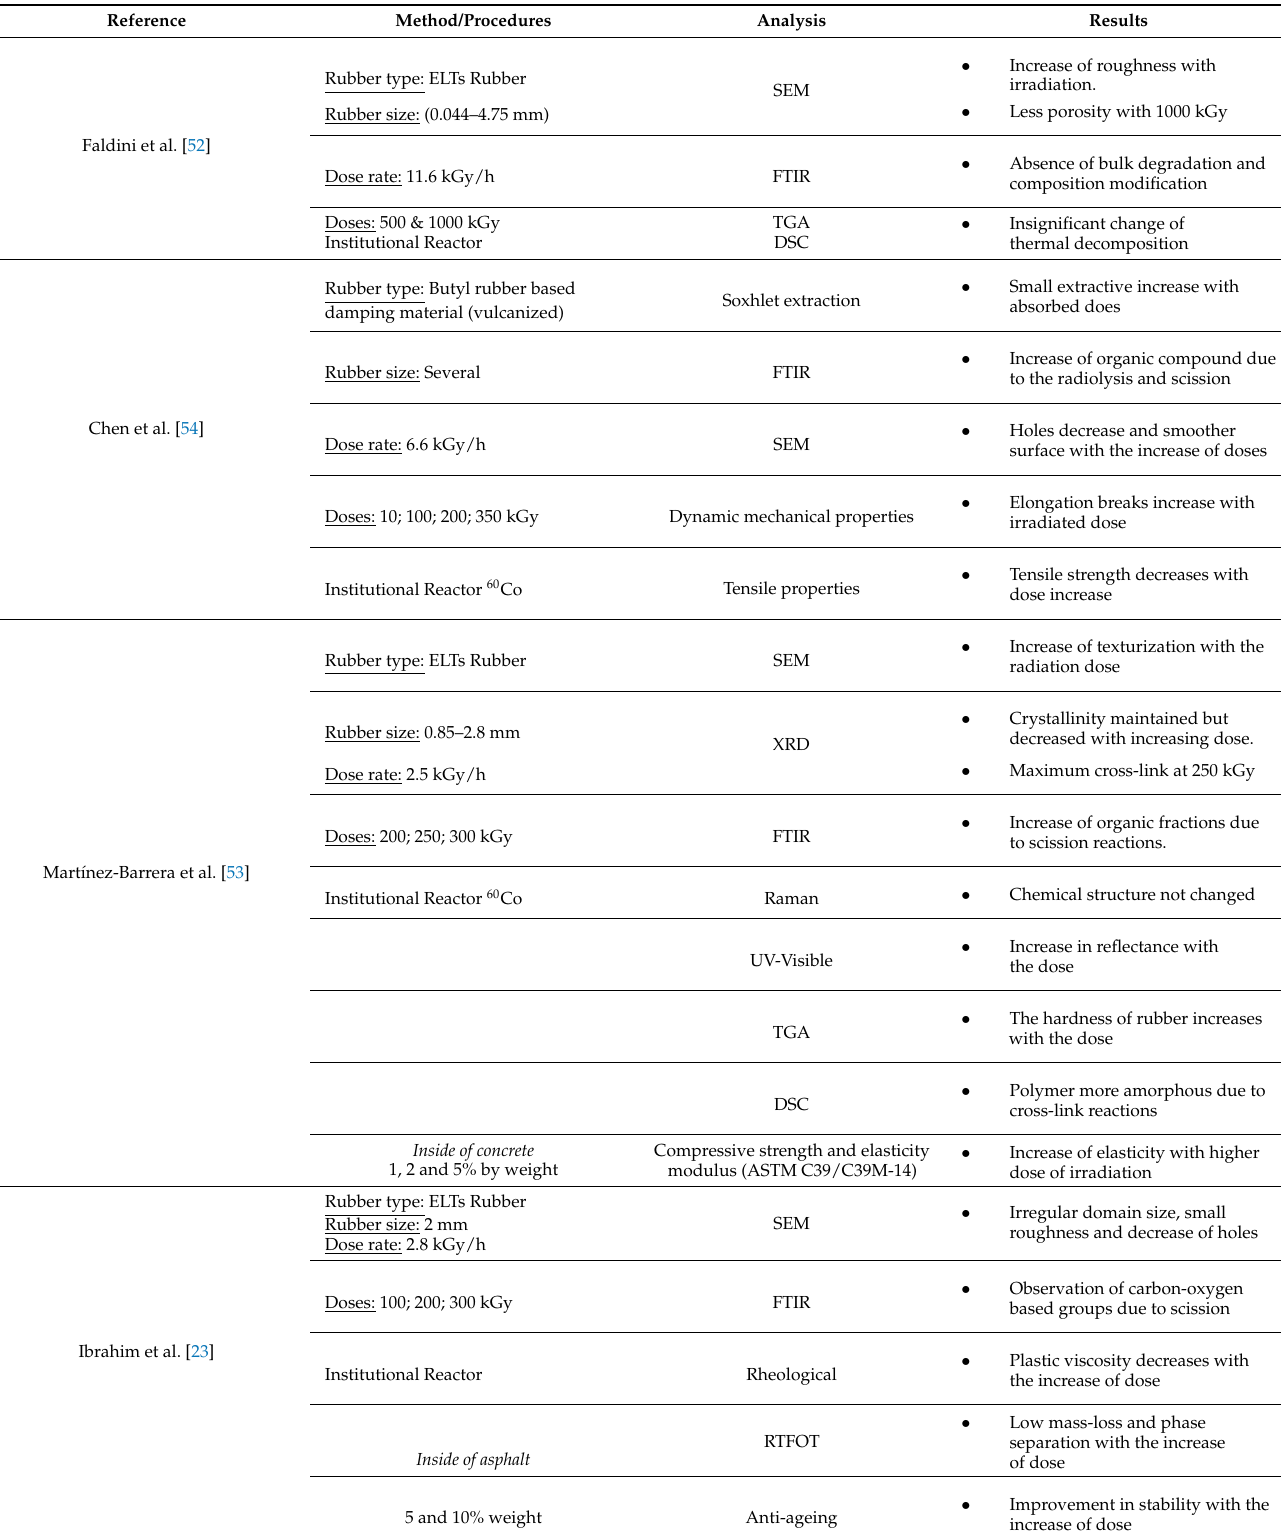
Table 1. Summary of studies on the procedures and results using gamma ray